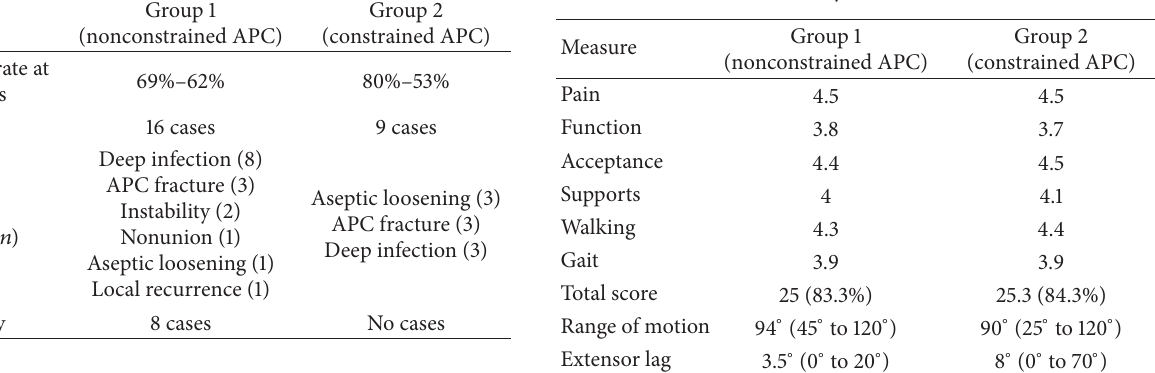
Table 4: Comparison of mean functional scores between groups (Musculoskeletal Tumor